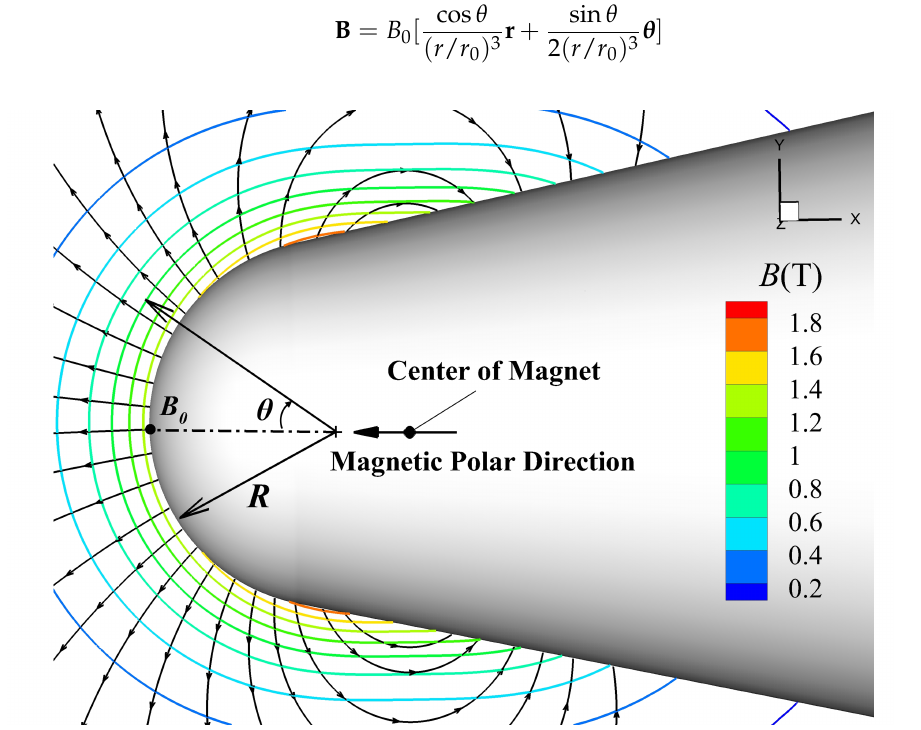
Figure 7. Diagram of sphere–cone blunt body with external magnetic field. Table 1. Freestream